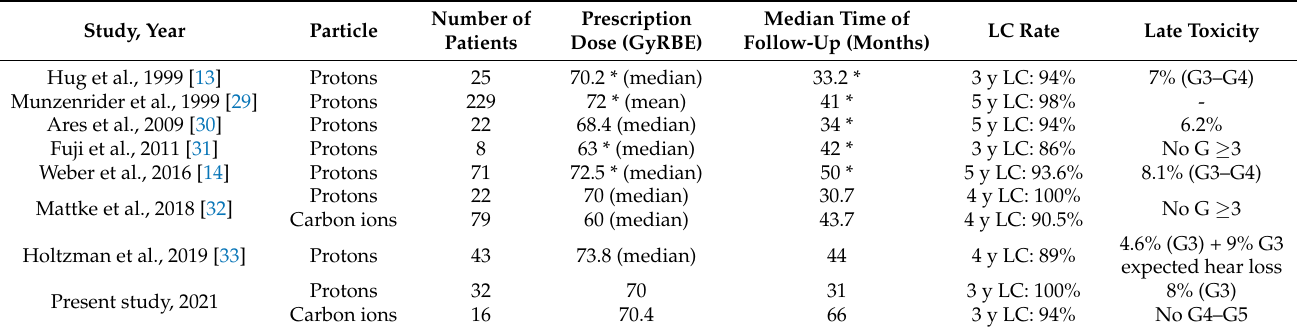
Table 3. Single institutional reports on PT and CIRT for chondrosarcoma of the skull base. Number of Particle